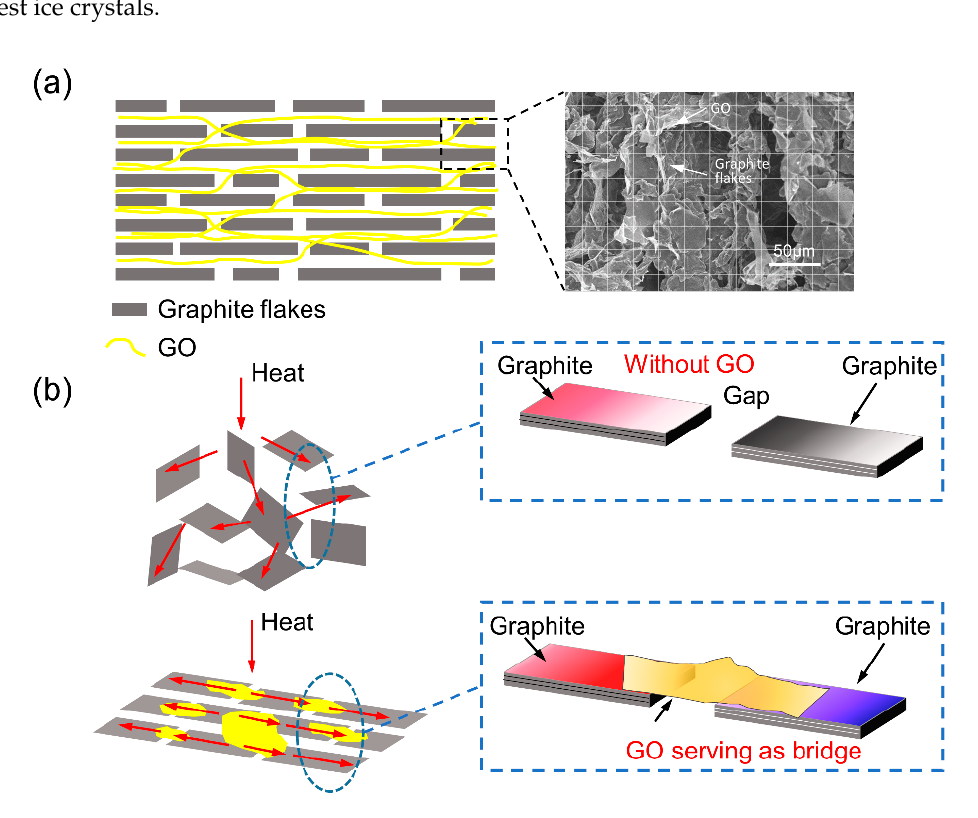
Figure 7. ( a ) Cross-section of the graphite and GO layer, indicating the arrangement. The right graph is the SEM cross-section image. ( b ) Schematic of the thermal conductive channel of random GP / PU and 3D-GP / PU with GO serving as bridge.